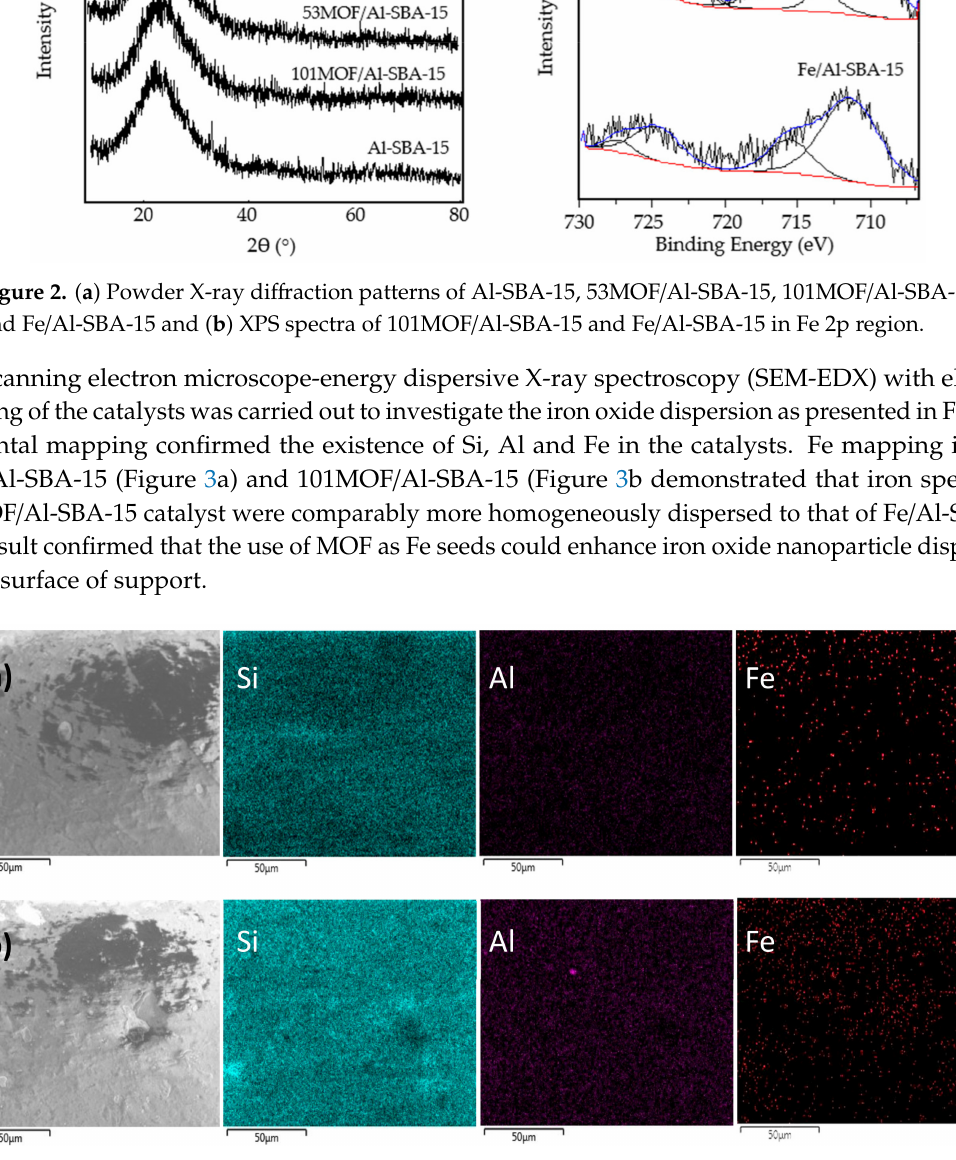
Figure 3. The SEM images for ( a ) Fe / Al-SBA-15 and ( b ) 101MOF / Al-SBA-15 and EDX elemental mapping profiles of the catalysts with Si (green), Al (purple) and Fe (red)